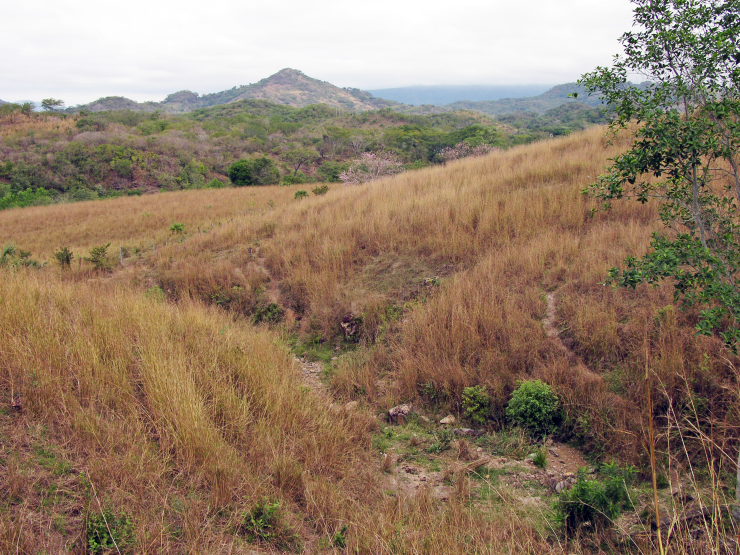
Brachypelma
emilia habitat near Las Varas, Nayarit state, Mexico. Photo: Rick C. West.